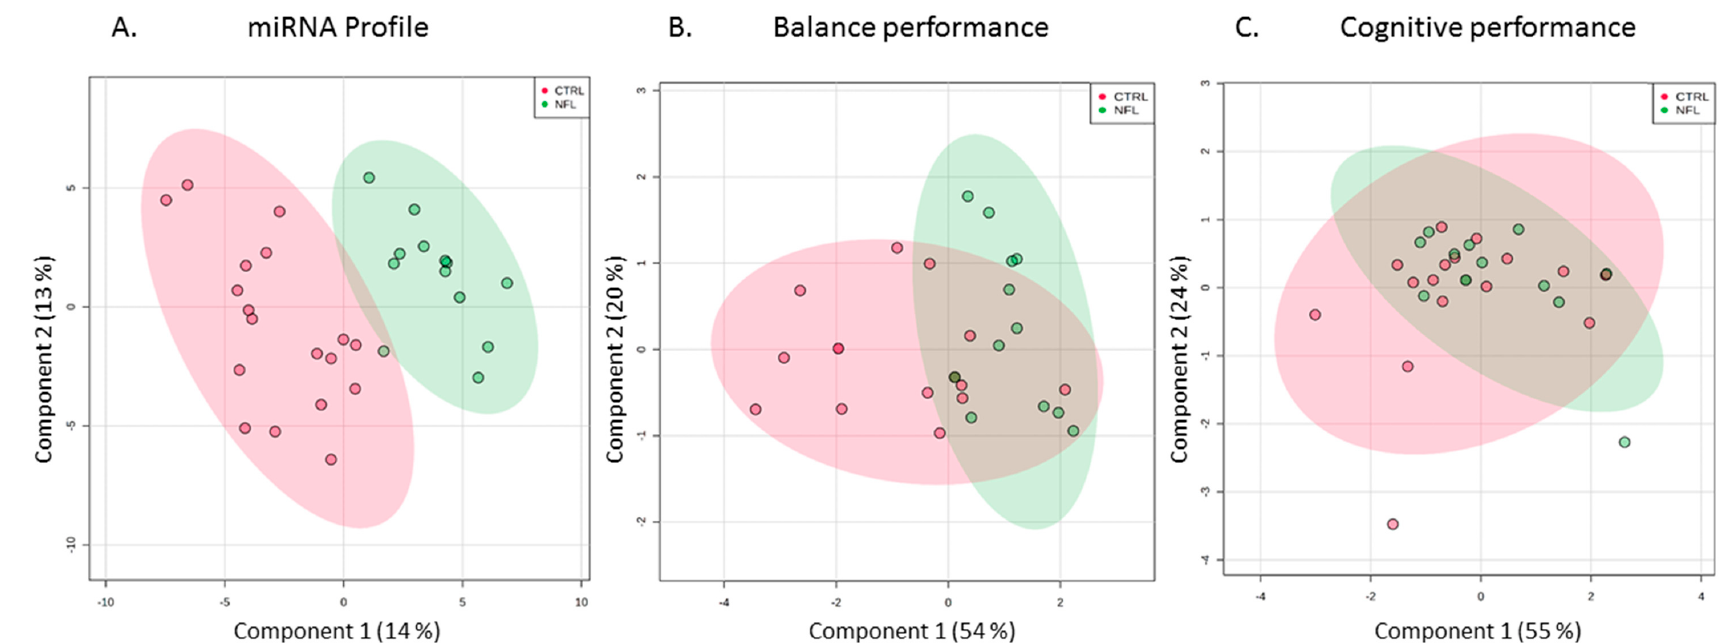
Figure 1. Salivary miRNA profiles differentiate former professional football athletes from peers. Partial least squares discriminant analysis (PLSDA) was applied to individual salivary miRNA profiles ( A ), balance performance measures ( B ), and neurocognitive scores ( C ) among professional athletes in the National Football League (NFL; n = 13; green) and control participants (CTRL; n = 18; red). The two-dimensional PLSDA plot based on saliva miRNA levels achieved complete separation of groups, while accounting for 27.5% of variance in the miRNA data.